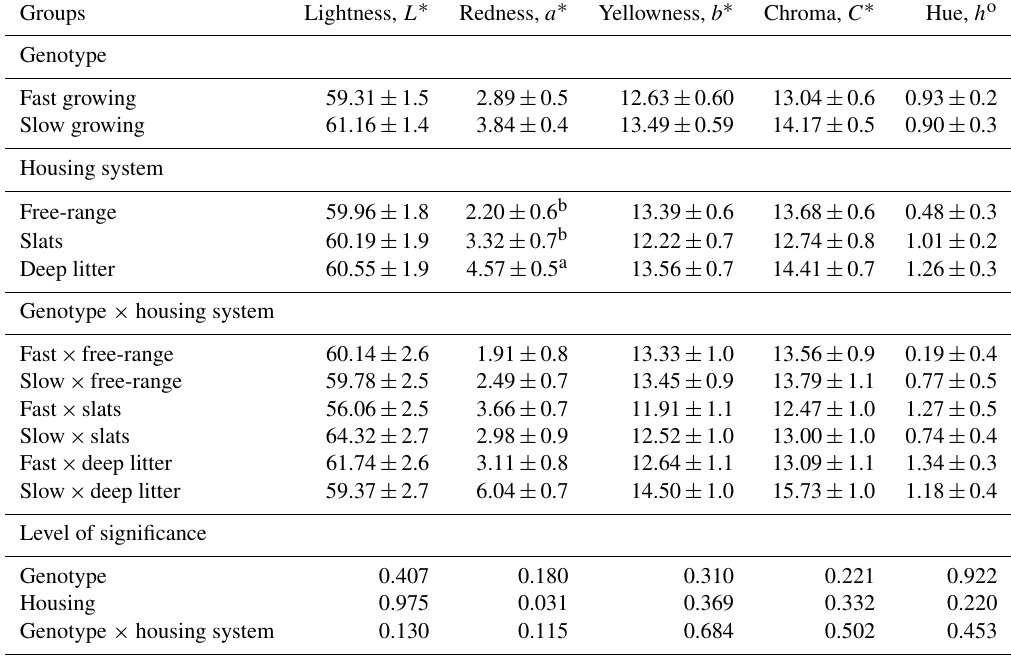
Table 3. Colour values of leg muscles of slow- and fast-growing broiler chickens either raised with free-range or indoor systems (either fully slatted or fully deep